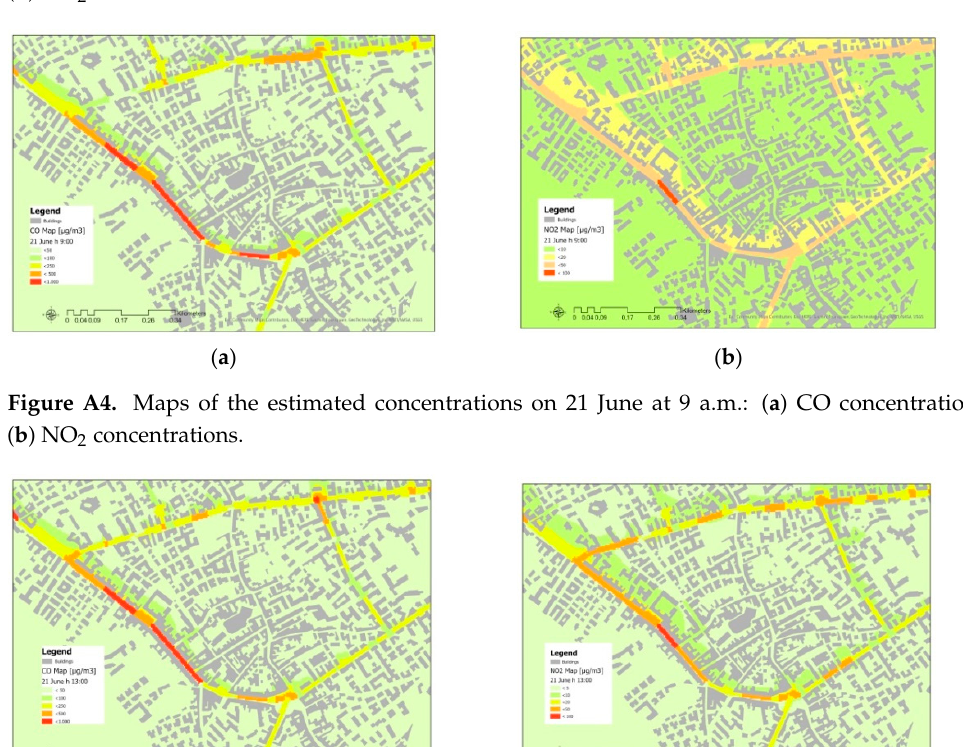
Figure A3. Maps of the estimated concentrations on 5 June at 5 p.m.: ( a ) CO concentrations; ( b ) NO 2 concentrations.